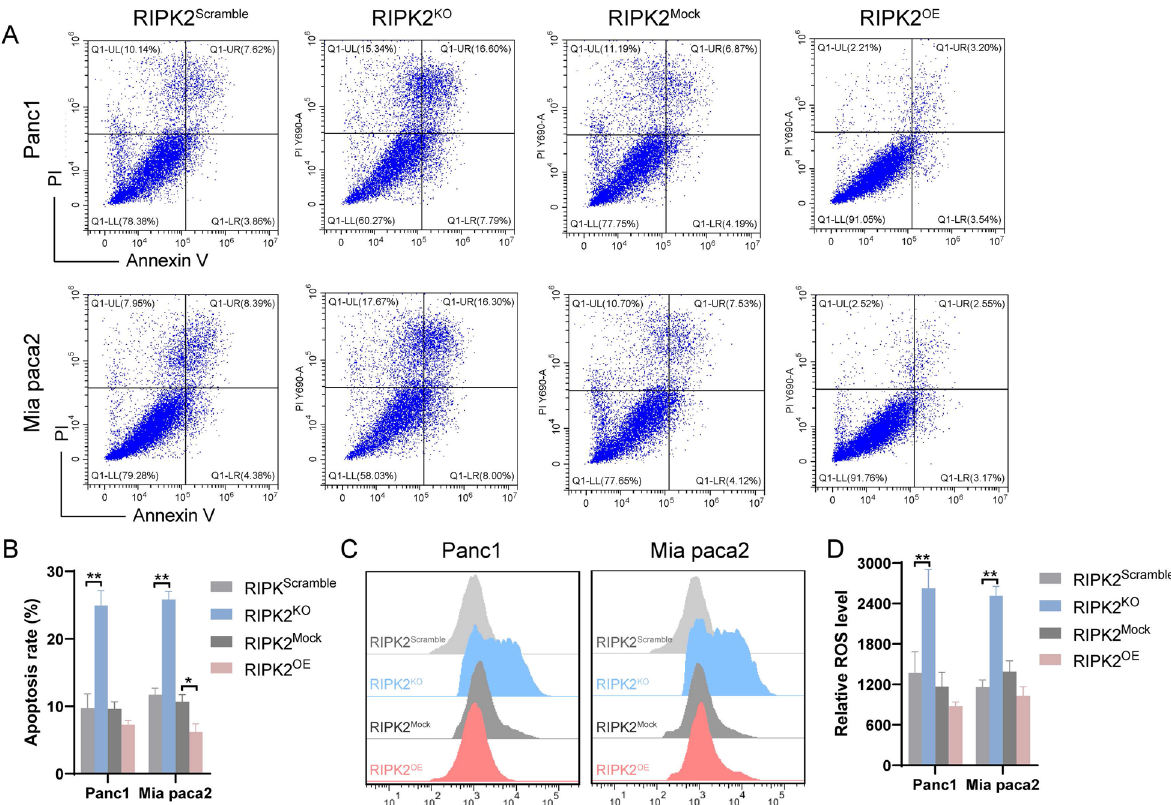
Fig. 5 Apoptosis and reactive oxygen species (ROS) level of pancreatic cancer cells. A Apoptosis assay of pancreatic cancer cells after RIPK2 knockout and overexpression. B Statistical analyses of apoptosis rate of pancreatic cancer cells. C ROS level assay of pancreatic cancer cells after RIPK2 knockout and overexpression. D Statistical analyses of relative ROS level of pancreatic cancer cells. *p < 0.05, **p <